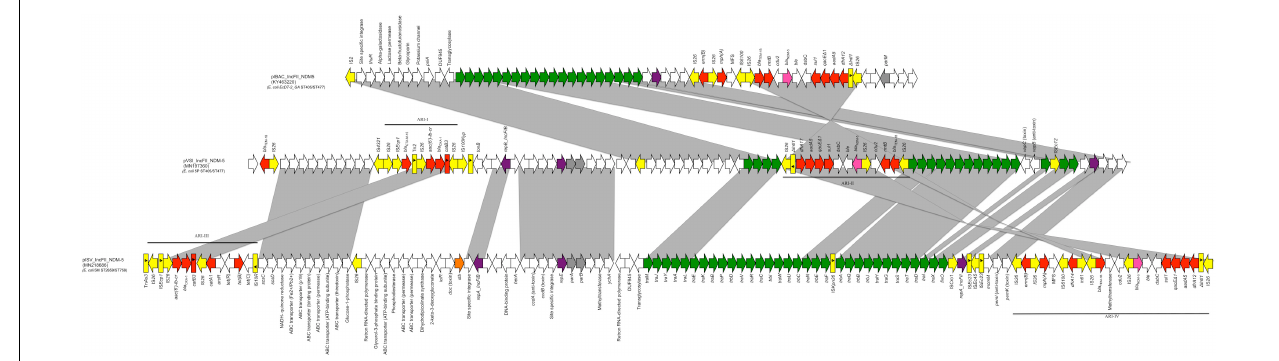
FIGURE 1 | Linear map of pIBA_IncFII_NDM5, pVSI_IncFII_NDM-5, and pISV_IncFII_NDM-5; Arrows show the direction of transcription of ORFs while rectangles show truncated ORFs. Replicons, partitioning genes, mobile elements, conjugal transfer genes, antibiotic resistance, bla NDM - 5 , other remaining genes and stability genes are designated by violet, gray, yellow, green, red, pink white, and orange, respectively. Gray shaded area shows the nucleotide similarity between the three plasmids. Different Antibiotic resistance islands (ARI) are marked by a horizontal black line.